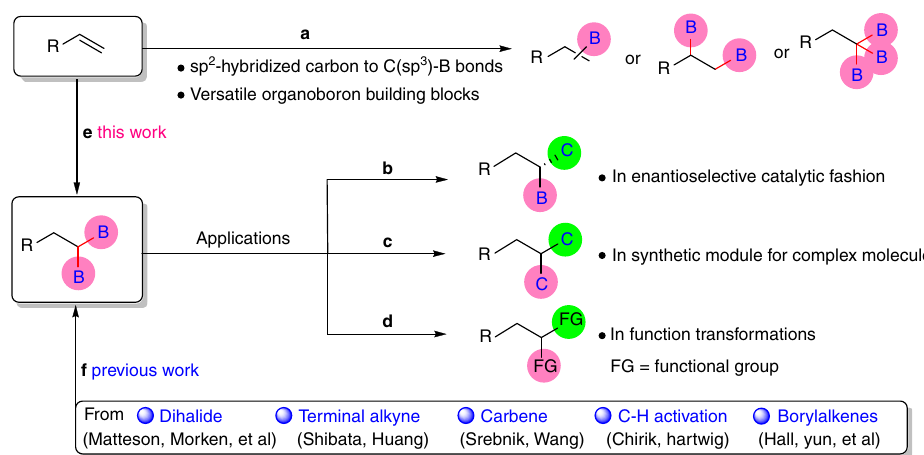
Fig. 1 Borations of alkenes, synthetic methods and applications of 1,1-diborylalkanes. Transition metals catalyzed synthesis of monoboration (e.g., Rh 23 , Fe 24 – 27 , Co 28, 29 , Ir 30 , Ru 31 ), 1,2-diboration (e.g., Rh 32, 33 , Pt 34 – 36 , Cu 37 , Ni 38 , Pd 39 and metal-free 40, 41 ) and 1,1,1-triboration 10 of alkenes ( a ). Construction of chiral molecules utilizing racemic or nonracemic 1,1-diborylalkanes 11 – 15, 42, 43 ( b ). Conversion C – B bonds to C – C bonds to afford complex molecules ( c ). Transformations of organoboron building blocks into a wide variety of functional groups 44,45 ( d ). Transition metal catalyzed synthesis of 1,1-diborylalkanes from terminal alkenes ( e ). Previous work was reported for preparation of 1,1-diborylalkanes from 1,1-dihalides 11, 21, 46 , terminal alkynes 47 – 49 , carbene insertion 50, 51 , hydroboration of borylalkenes 42, 43 or C-H activation 52 – 54 ( f